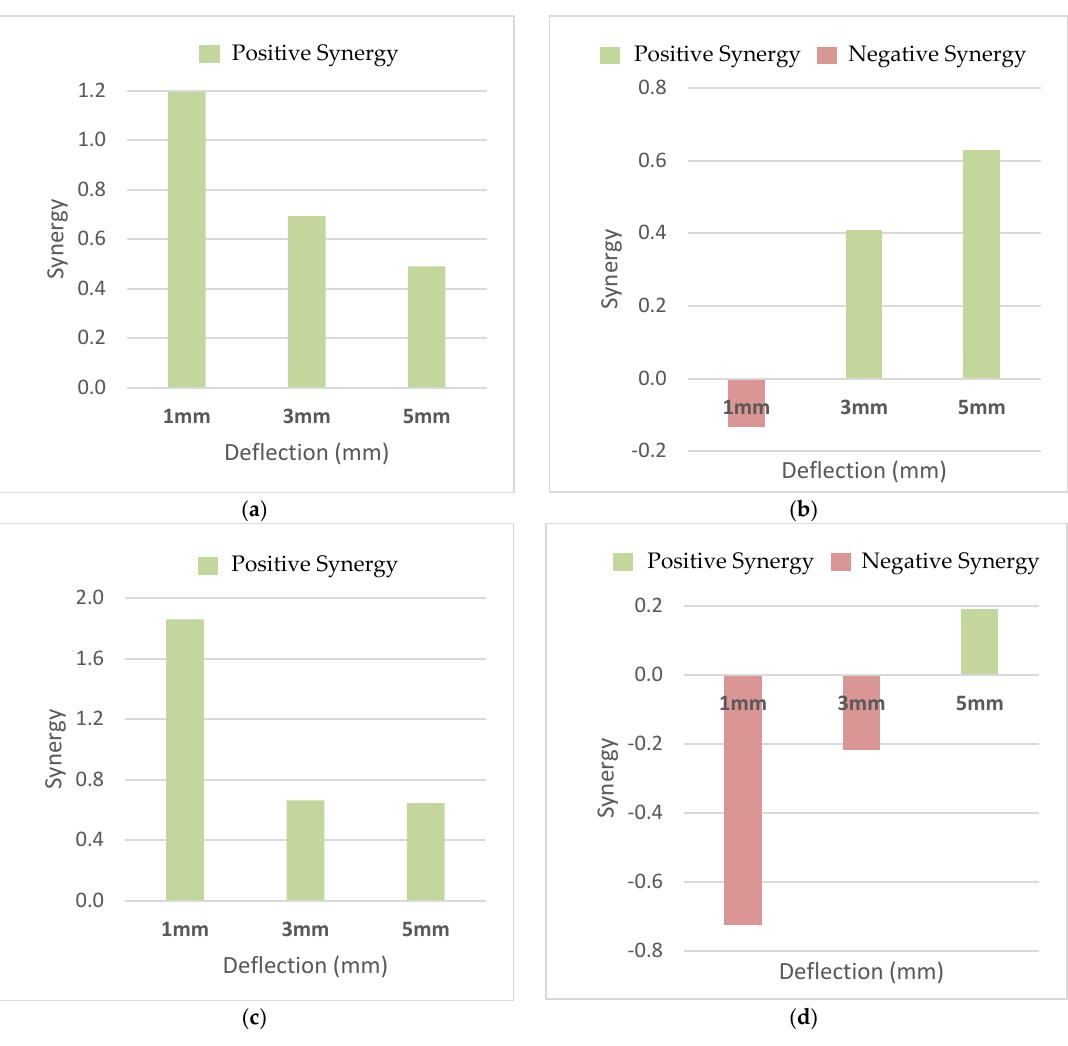
Figure 11. The synergistic effect in shear energy for ( a ) F6U3, ( b ) F6S3, ( c ) F6E3, and ( d ) F6N3 HyFRC.